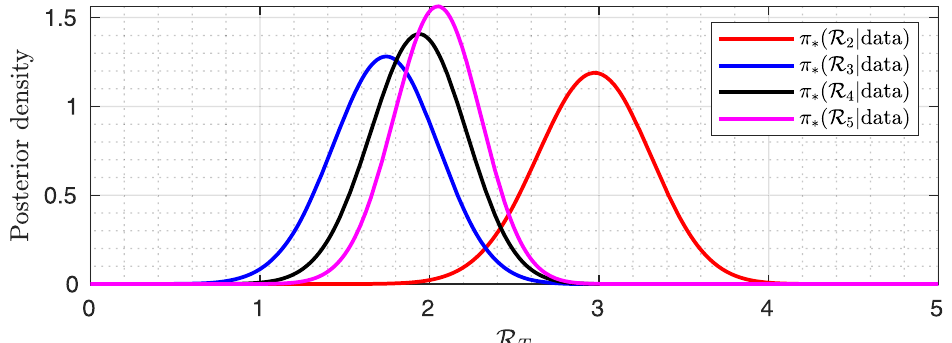
Fig. 4. Real-time data for the variation of p * ( R T | D ) for R T over 5 days with g =1/5. Coverage: Italy from 1 − 5 March 2020.